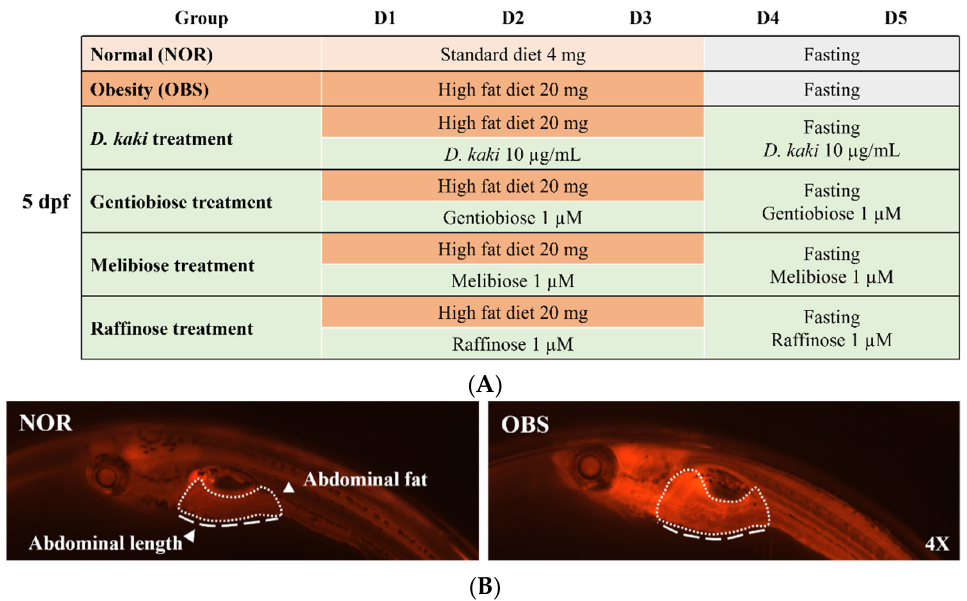
Figure 1. Zebrafish as an obesity model. Experimental setup ( A ). Comparison of the abdominal length and the abdominal fat between the normal group (NOR) and obesity group (OBS) stained with Nile red staining and observed under florescence microscope at day five of the experiment ( B ).